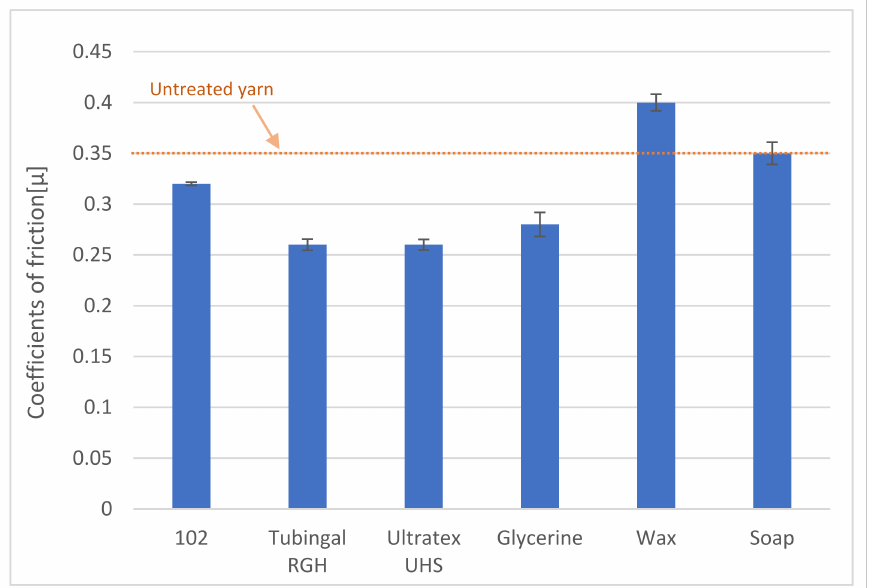
Figure 6. Coefficients of friction were determined for the paper yarn before and after applying finishing